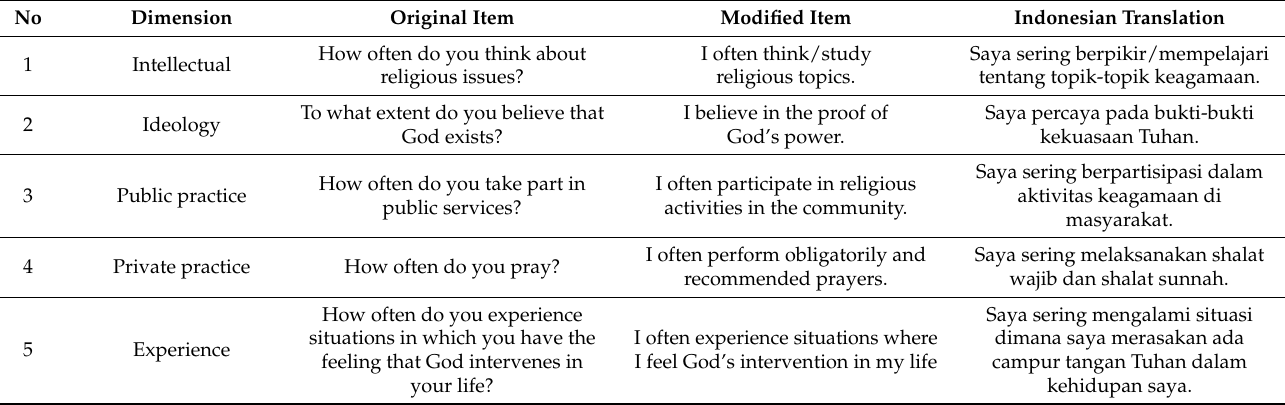
Table A1. The Centrality of Religiosity Scale (CRS).